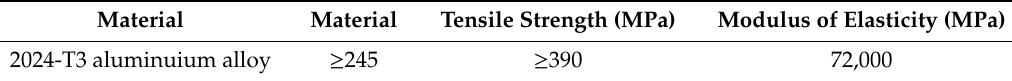
Table 2. 2024-T3 aluminum alloy performance parameters.